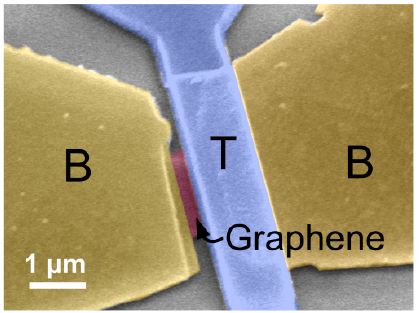
Figure 3. False color SEM image of a double-clamped beam graphene switch as-fabricated. T and B denote top and bottom electrodes, respectively.